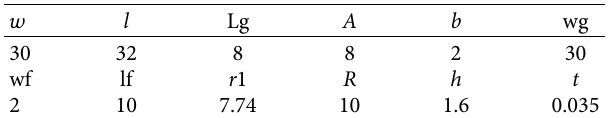
Table 1: Parameter value in